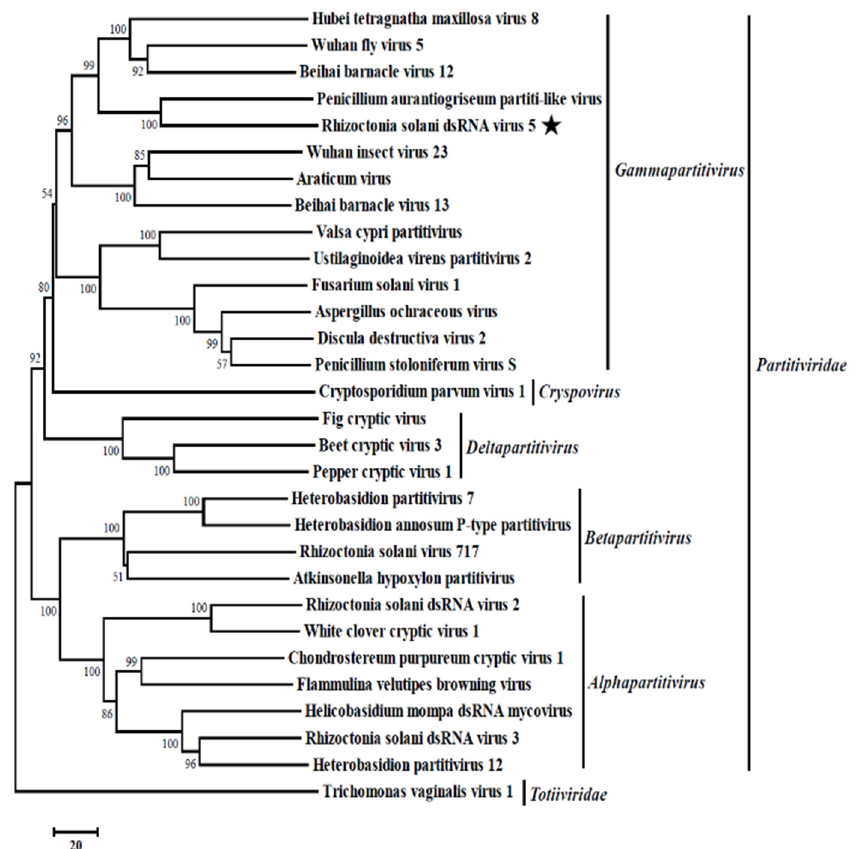
Figure 3. Phylogenetic relationship of RdRp genes of Rhizoctonia solani dsRNA virus 5 (RsRV5) and selected dsRNA viruses. An unrooted phylogenetic tree was constructed by a neighbor-joining method based on multiple amino acid sequence alignments of the RdRp using MEGA6.0. Bootstrap values (%) obtained with 1000 replicates are indicated on branches. Rhizoctonia solani dsRNA virus 5 (indicated with black star) was grouped into the genus Gammapartitivirus . Relate viruses